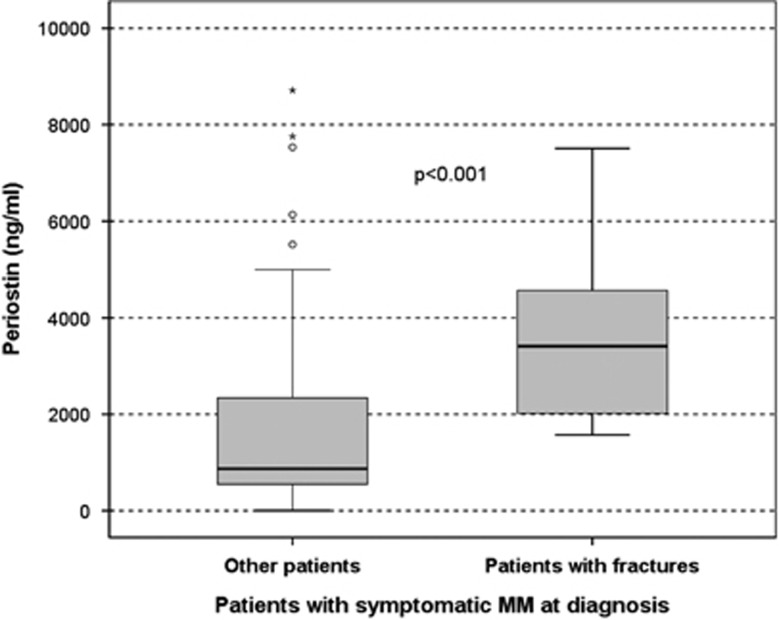
Bone marrow plasma levels of periostin are highly elevated in newly diagnosed patients with symptomatic MM and pathological fractures.